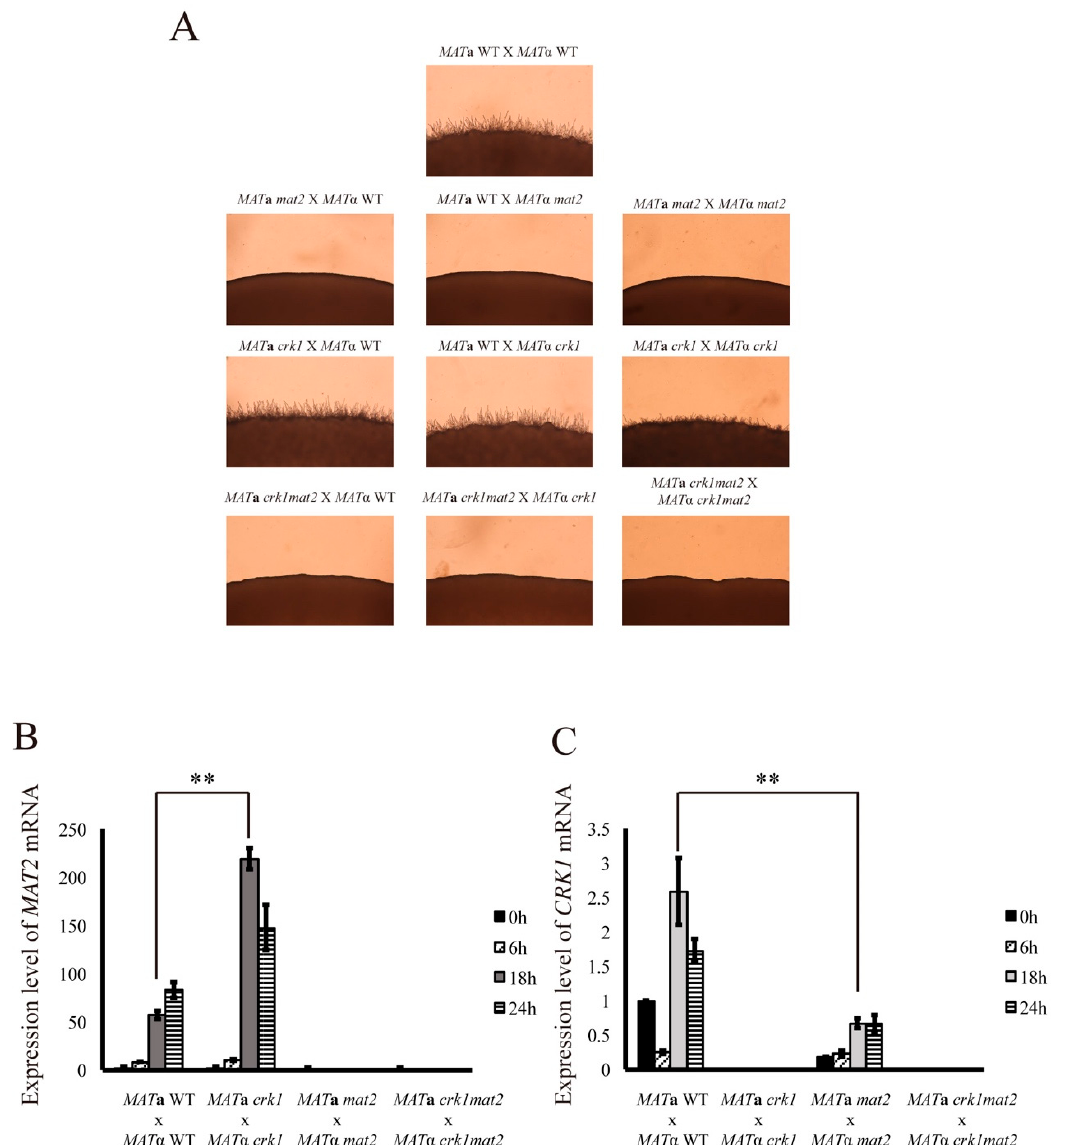
Figure 4. Sexual differentiation in the crk1 mutant was blocked by the mutation of MAT 2 and CRK1 expression was reduced in the bilateral mat2 mutant cross. ( A ) C. neoformans MAT a and MAT α strains were crossed as indicated. Mating was conducted on V8 agar plates and incubated at 26 ◦ C in the dark. Photos were taken 24 h post-incubation at 100 × magnification. Bilateral crosses involved the MAT a and MAT α wild-type and crk1 , mat2 , and mat2crk1 double mutants were conducted. Samples were collected at 0, 6, 18 and 24 h post-incubation and subjected to RNA extraction. The expression of MAT2 ( B ) and CRK1 ( C ) during bisexual mating was examined by real-time qRT-PCR analysis. Triplicate reactions for each sample were conducted. Error bar represents the standard deviation from the mean of three replicates. The results were normalized to C. neoformans GPD1 expression. (** indicates p < 0.005).